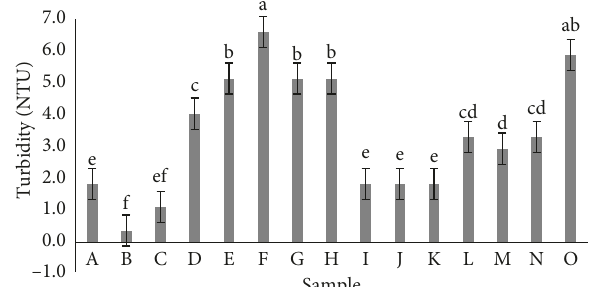
Figure 1: pH values for 15 samples of treated water. A-B: Sg. Ramal ; C-E: Section 8, Bandar Baru Bangi ; F-I: Section 16, Bandar Baru Bangi ; J, K, and O Section 3, Bandar Baru Bangi ; L-N: Section 15, Bandar Baru Bangi . All results are expressed in mean ± SD. a-g Values for the samples which have different letters are signifi- cantly different ( p < 0 .